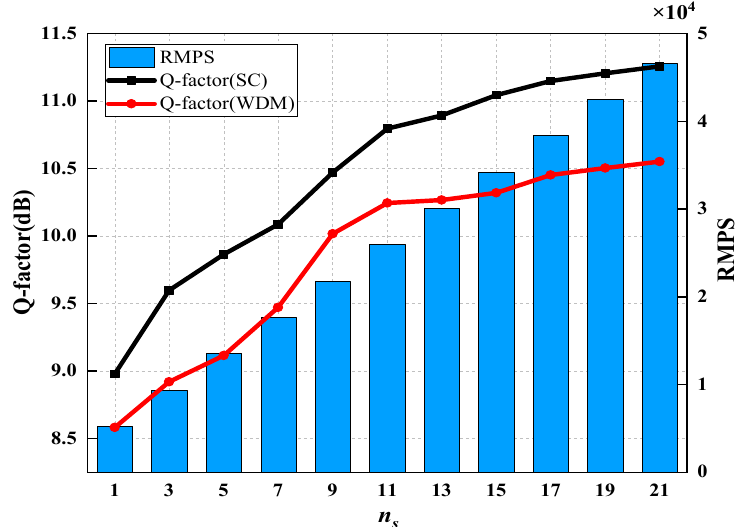
Figure 13. Q-factor versus the number of time steps n s with the corresponding RMPS for 28 GBaud PDM-16QAM SC and 3-channel WDM systems.